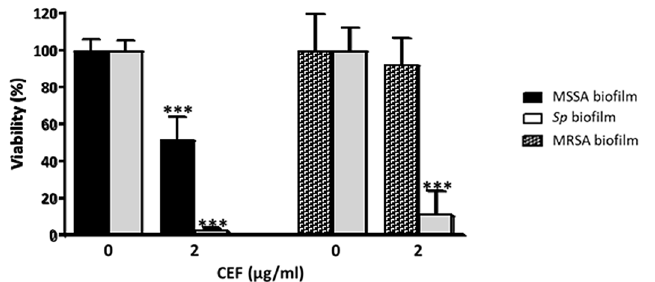
Figure 6. Treatment with CEF of MSSA/MRSA- Sp mixed biofilms (Disaggregation of mixed biofilms). Mixed biofilms were first incubated for 4 h at 34 °C, then washed with sterile H 2 Od and incubated with 2 µg/ml of CEF for 1 h at 37 °C. The MIC of CEF for the S. pneumoniae strain was 0.12 µg/ml, for the MSSA strain was 1.25 µg/ml and for the MRSA strain was 2.5 µg/ml. Black bars correspond to MSSA, grey bars correspond to S. pneumoniae , and grey patterned bars represent MRSA viable cells within the mixed biofilms. Data represent the average of at least three experiments. Standard deviation bars are shown, and asterisks mark statistically significant results (two-tailed Student’s t test: *** P < 0.001) when comparing the treatment versus the non-treated